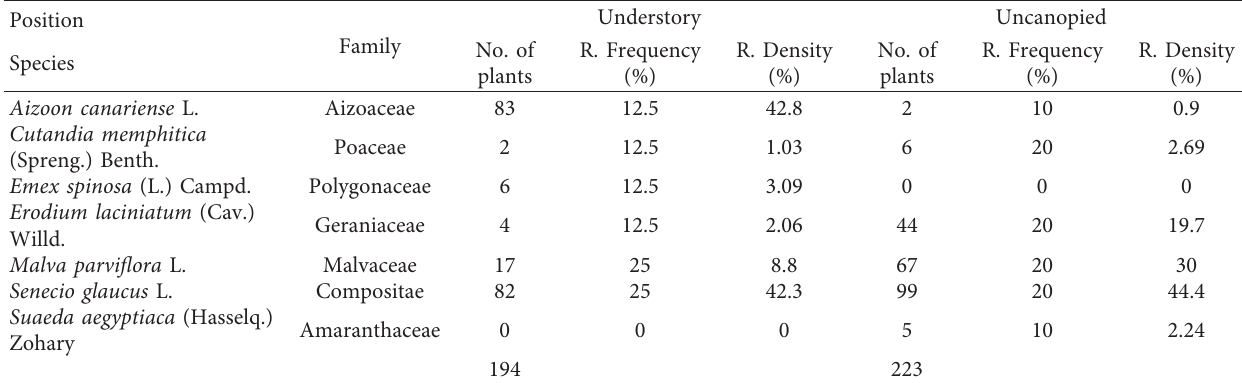
Table 2: Mesquite-associated plant species in the study